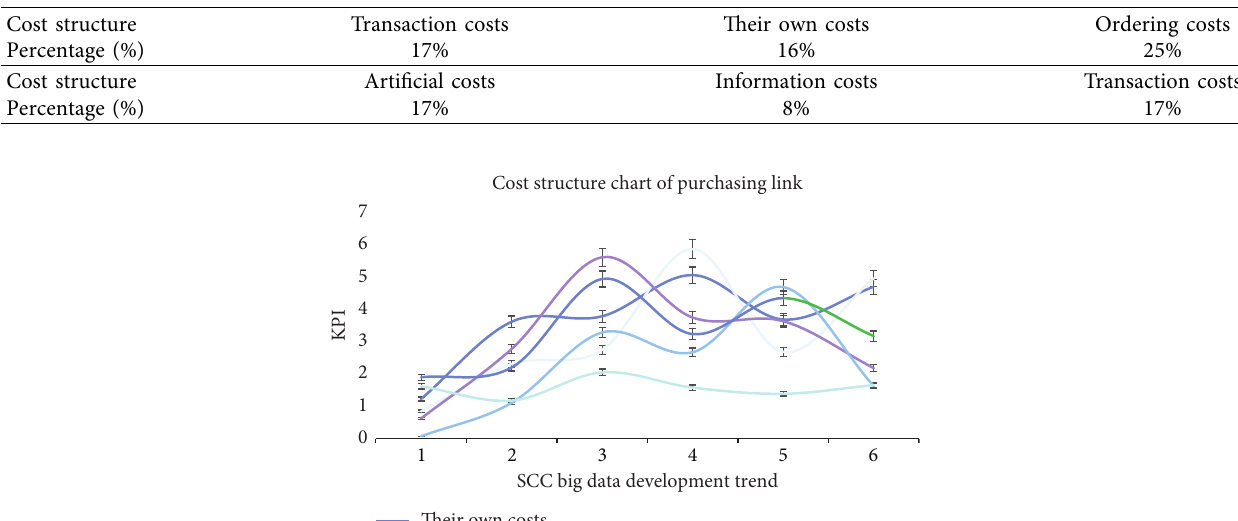
Table 3: Cost composition chart of the procurement link.